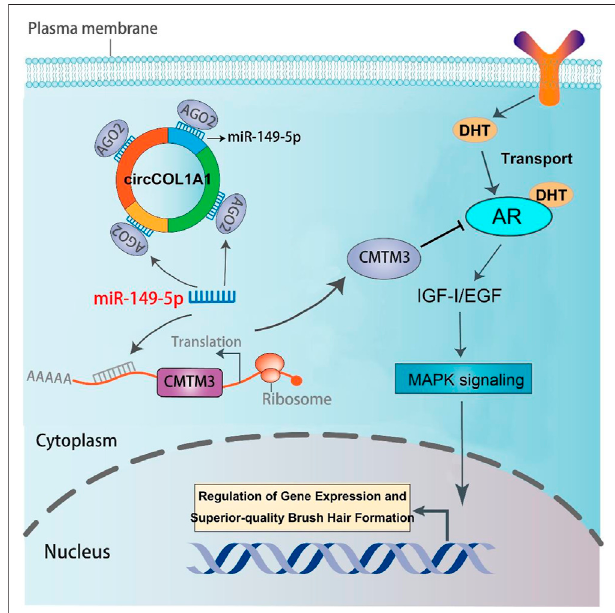
FIGURE 10 | The regulatory model of the circCOL1A1/miR-149-5p/ CMTM3/AR axis in goat hair follicle stem cells in superior-quality brush hair